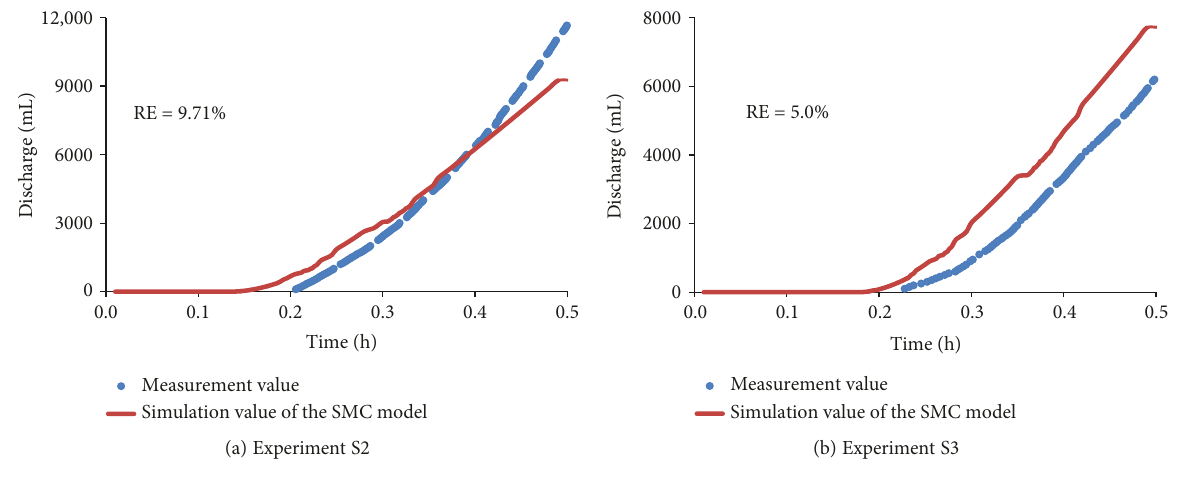
Figure 11: Comparison of the measured and SMC-simulated value of the